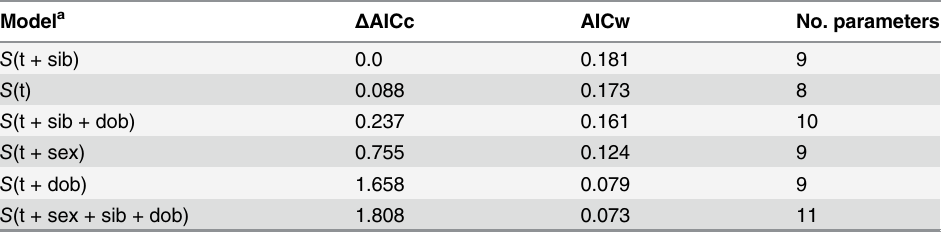
Table 1. Set of competing models (within 2 Δ AICc of top model) that includes biological covariates in fl uencing neonatal white-tailed deer survival at Fort Bragg Military Installation, North Carolina, 2011 –